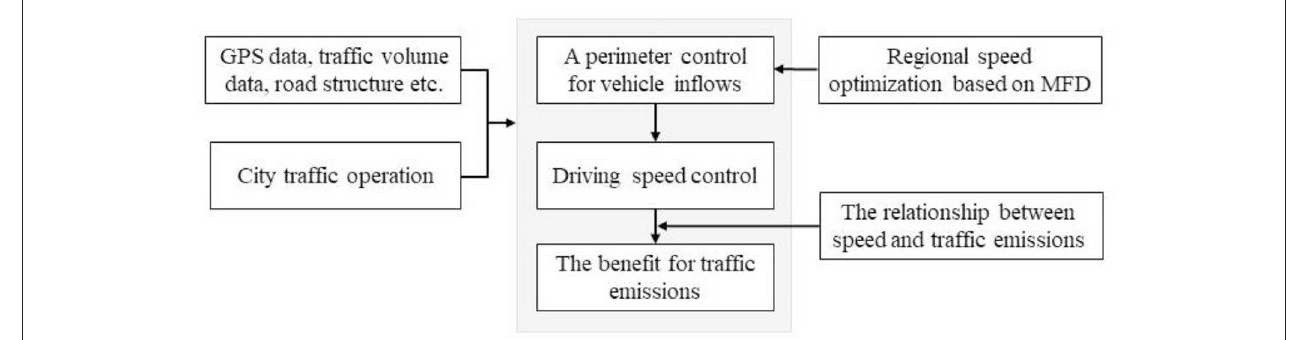
FIGURE 1 | Overview of calculation process.